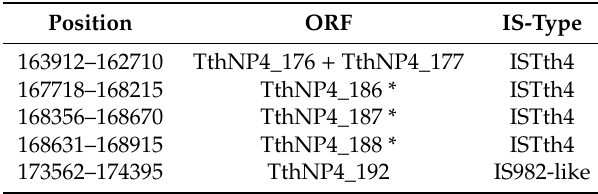
Table 2. Putative transposases located within the denitrification cluster of TthNAR1 strain. Typology of the transposases have been deduced according to the ISfinder database (https: // isfinder.biotoul.fr / ). Position ORF